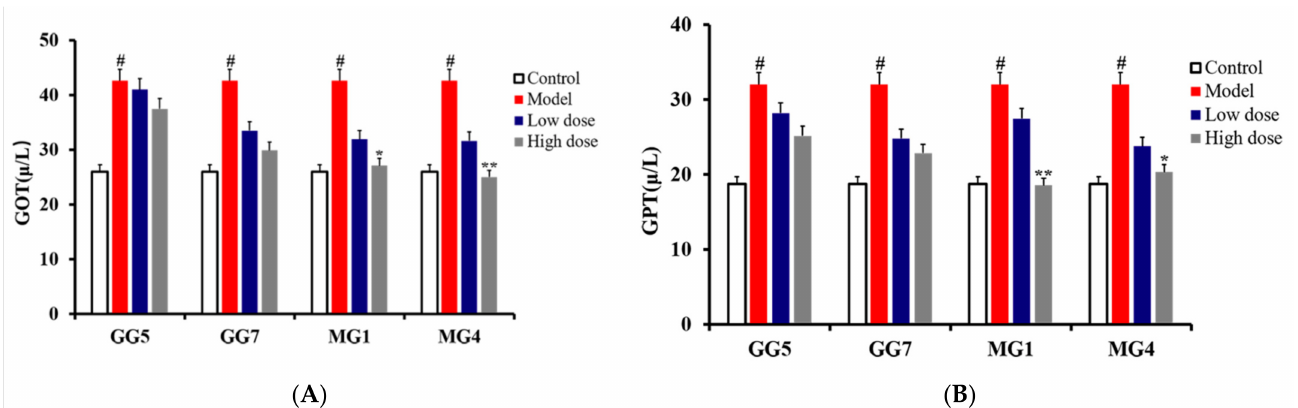
Figure 5. Effect of Ginseng on WBC ( A ) and LYM ( B ) in the blood of rats with liver injury induced by paclitaxel (compared with control group, # p < 0.05; compared with model group, * p < 0.05 and ** p < 0.01).